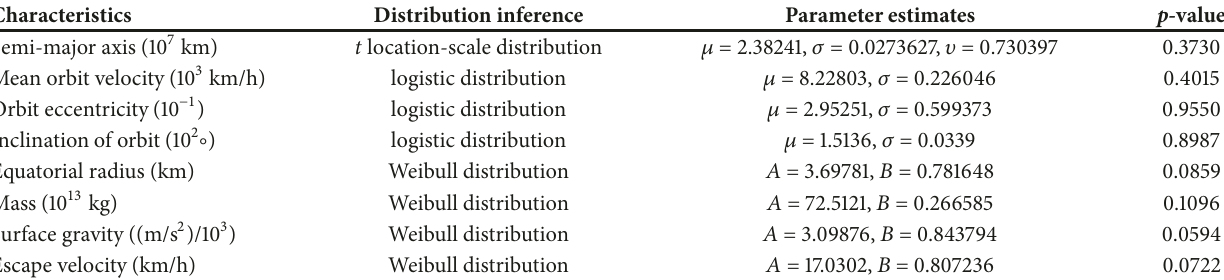
Table 4: The distribution inference in each orbital or physical characteristic (Pasiphae group).